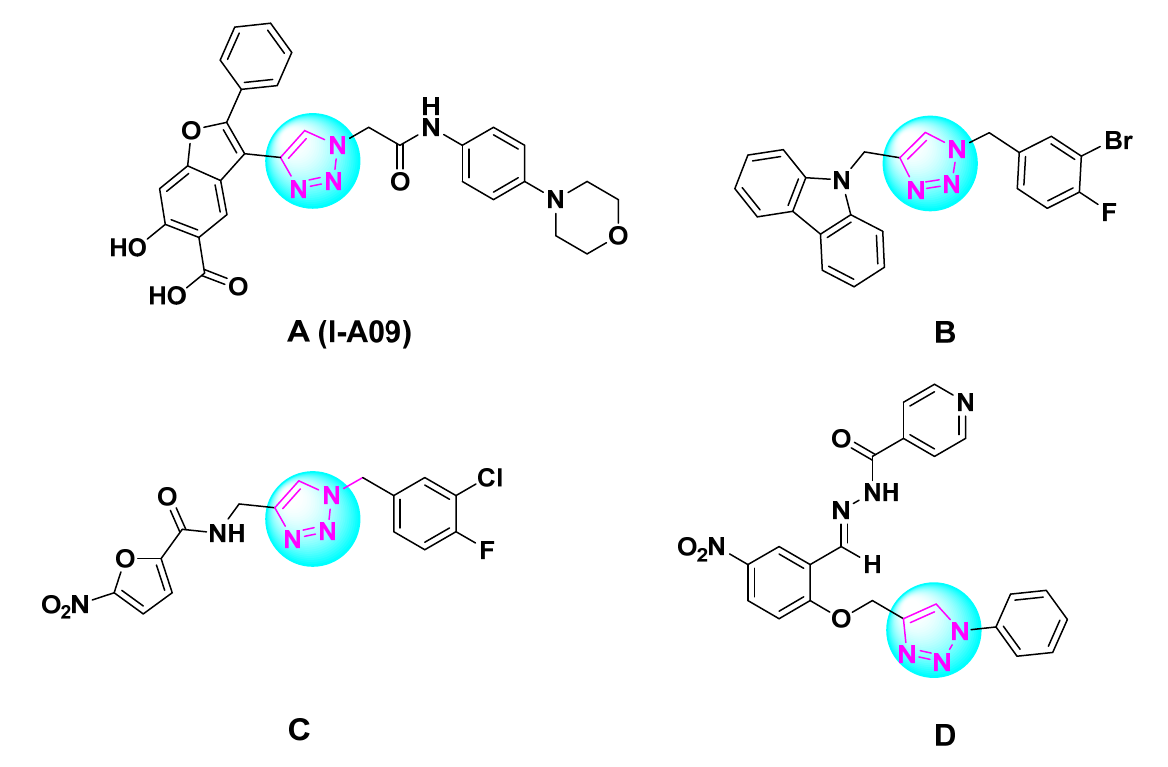
Figure 2. Representative examples of 1,2,3-triazole derivatives having antitubercular activity.